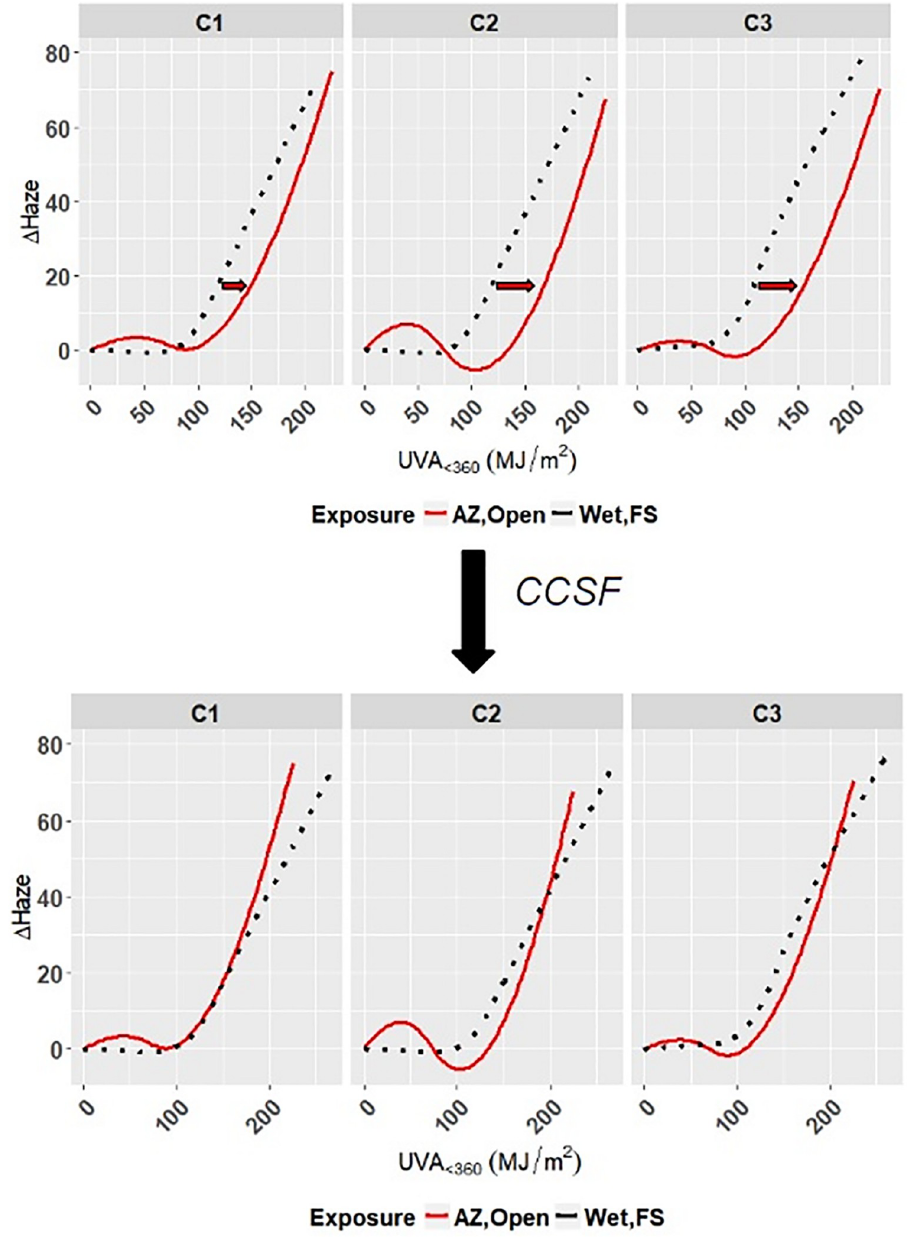
Fig 12. Example of scaling the model curve for an accelerated exposure (Wet-FS) by cross-correlation scale factor to minimize the RMSE with a given outdoor exposure model curve (Arizona-Open).